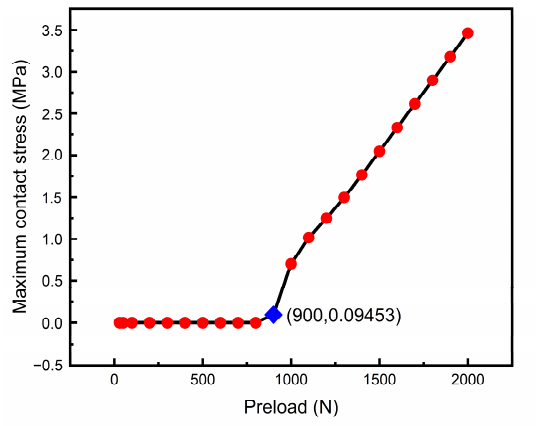
Figure 11. The relationship curve between preload and the maximum contact stress of top and bottom end faces of inner spacer.